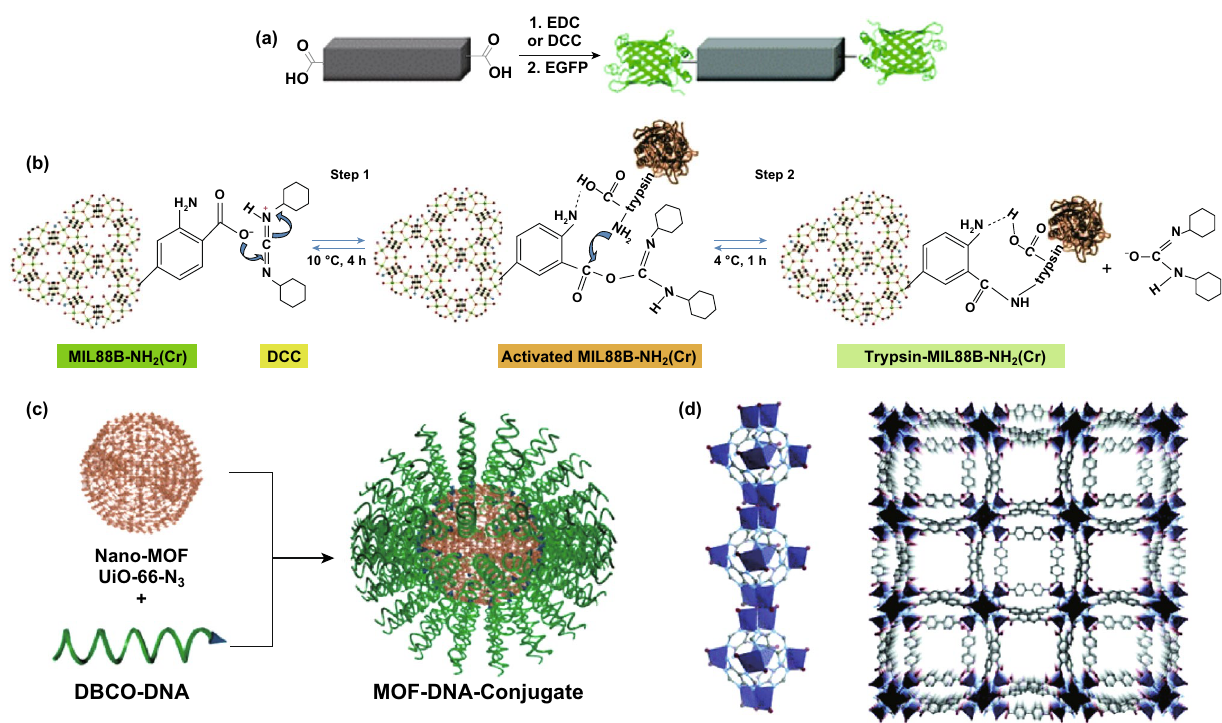
Fig. 3 a Activation of the 1D-polymer, [(Et 2 NH 2 )(In(pda) 2 )] n , with EDC or DCC to conjugate with EGFP. Reproduced with permission from Ref. [62]. Copyright 2011, The Royal Society of Chemistry. b DCC activation of MIL-88B-NH 2 (Cr) and following trypsin immobilization. Reproduced with permission from Ref. [63]. Copyright 2012, Wiley-VCH. c Schematic illustration of surface functionalization of UiO-66-N 3 nanoparticles with DNA through a click reaction with DBCO-DNA. Reproduced with permission from Ref. [68]. Copyright 2014, American Chemical Society. d The crystal structure of bio-MOF-1. The MOF consists of zinc—adeninate columns linked together into a 3D framework by BPDC linkers to generate a material with 1D channels. Reproduced with permission from Ref. [77]. Copyright 2009, American